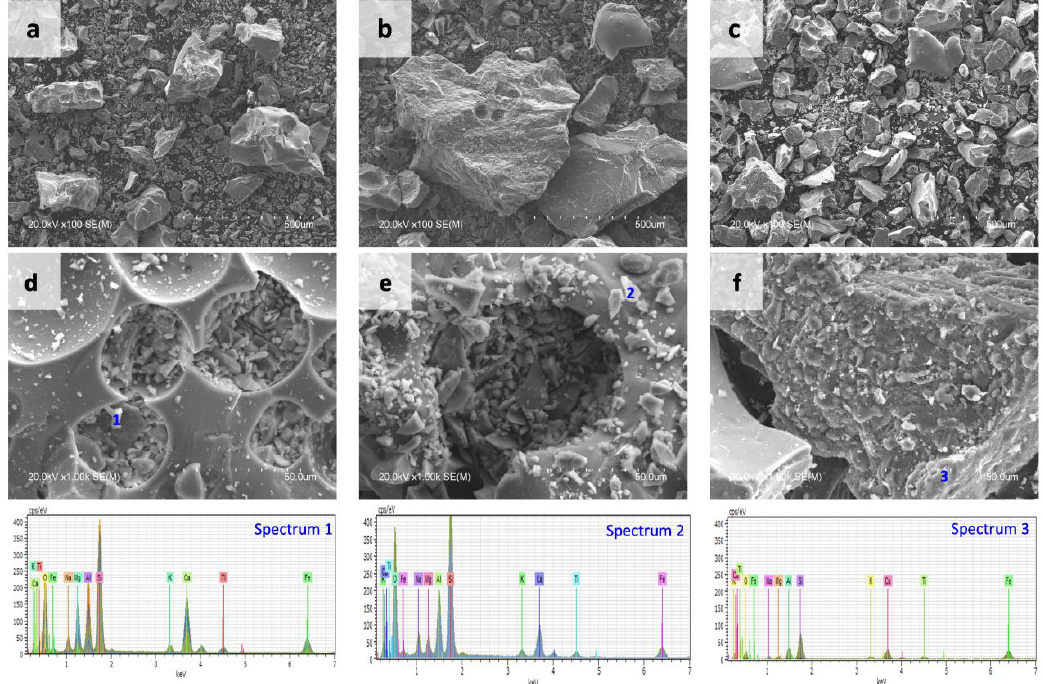
Figure 6. SEM micrographs of volcanic materials: ( a ) FVA 500µm; ( b ) CVA 500µm; ( c ) VL 500µm; ( d ) FVA 50 µ m; ( e ) CVA 50 µ m; and ( f ) VL 50 µ ( d ) FVA 50µm; ( e ) CVA 50µm; and ( f ) VL 50µm.